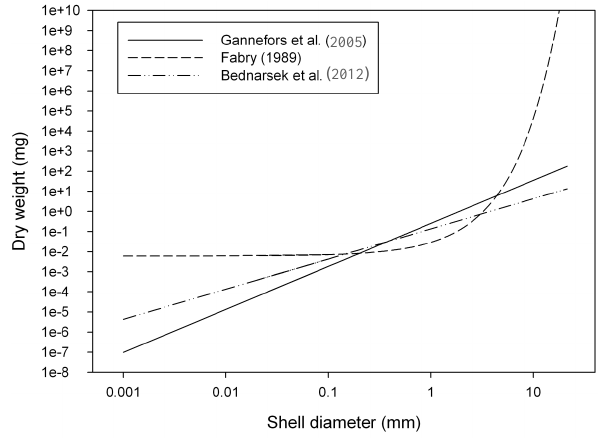
Figure B1. Shell diameter to dry weight relationships for Limacina helicina derived by three di ff erent